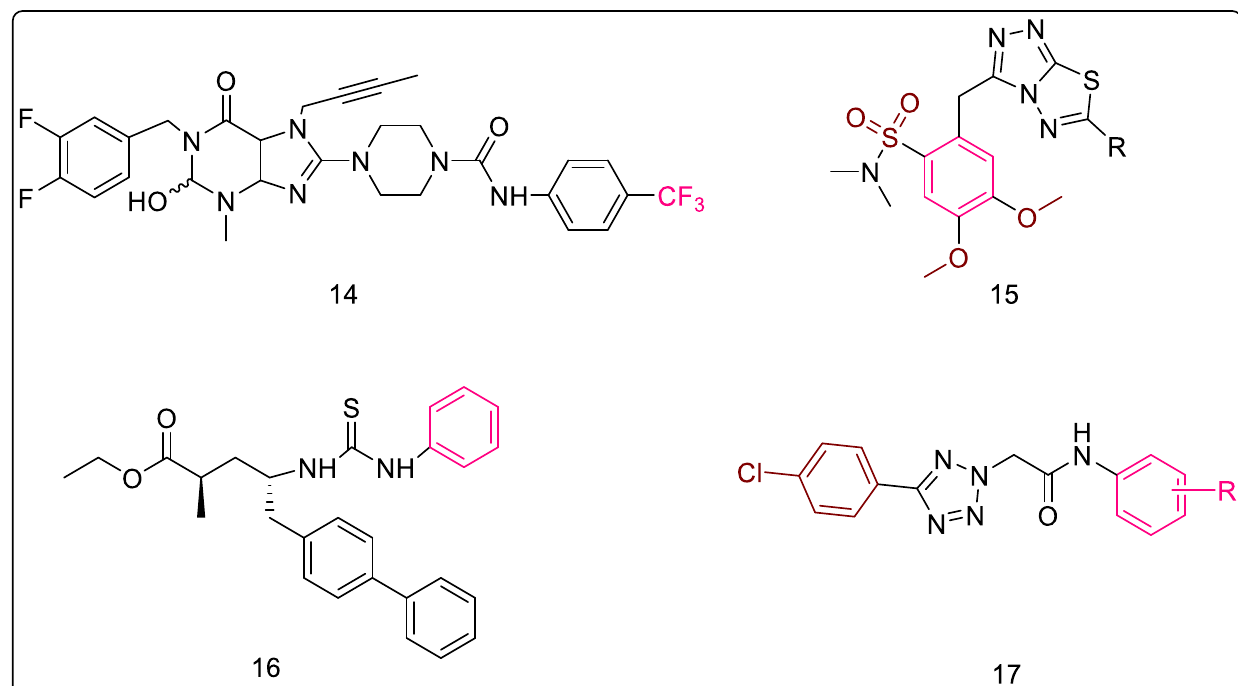
Figure 5. Classes of MurB inhibitors. ( 14 ) Purine-2,6-dione linked piperazine derivatives. ( 15 ) Tria- zolo-thiazole derivatives. ( 16 ) Sacubitril-based thiourea. ( 17 ) Tetrazolyl